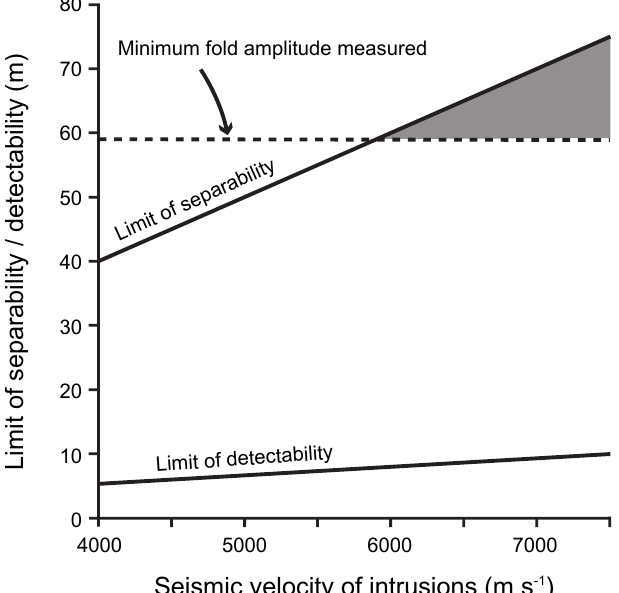
Figure 11: Graph showing the limits of separability and detectability for the seismic data, which has a fre- quency of ~25 Hz, if velocity of the igneous intru- sions range from 4000–7500 m.s -1 [Magee et al. 2015]. The minimum fold amplitude measured (i.e. 59 m) is shown, revealing that intrusion velocities of ≥ 5900 m.s -1 are required for sill thickness to equal measured fold amplitudes